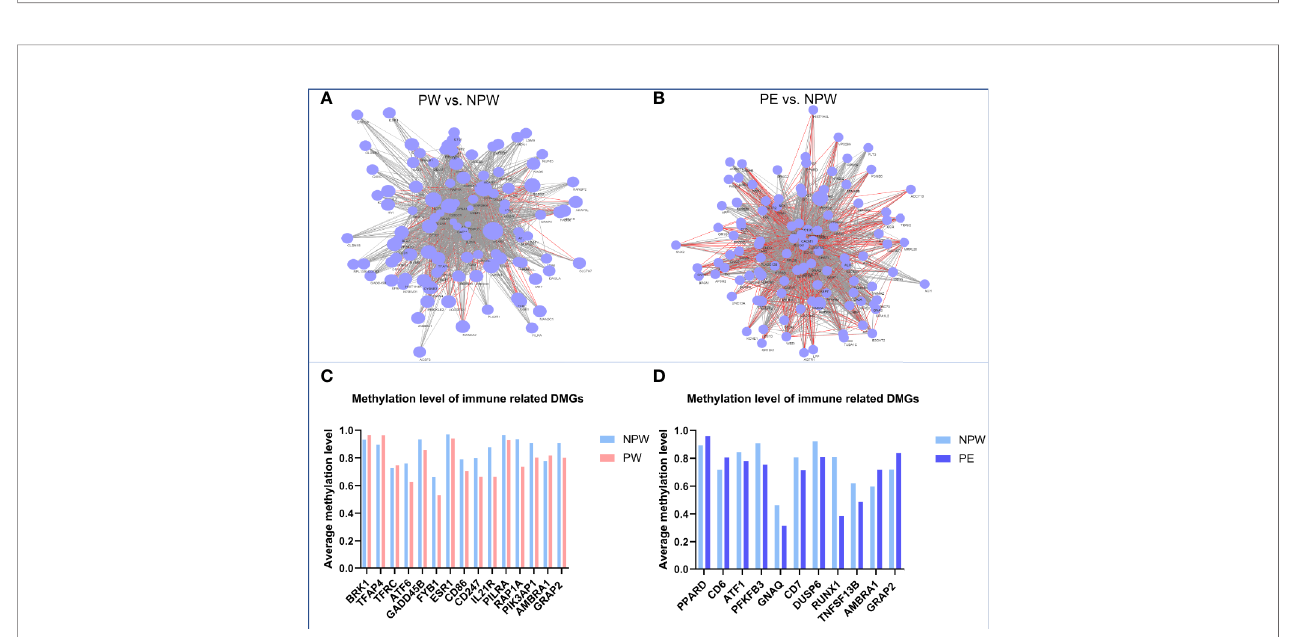
FIGURE 7 | Network diagram of methylation levels of signi fi cant DMGs and cell subset modi fi cation related DMGs in each KEGG pathway in the PW and PE groups. (A) Methylation levels of the signi fi cant DMGs in 201 KEGG pathways in the PW group compared to those in the NPW group. The larger the node is, the higher the methylation level of the genes in the PW group compared to the NPW group. The gray line between two genes represents the near-identical methylation changes (both increased and decreased) between the two compared groups, while the red line represents opposite methylation changes between the groups. (B) Methylation levels of the signi fi cant DMGs in 196 KEGG pathways in the PE group compared to the NPW group. The larger the node is, the higher the methylation level of the gene in the PE group compared to the NPW group. The gray line between two genes represents the near-identical methylation changes (both increased and decreased) between the two compared groups, while the red line represents opposite methylation changes (one hypermethylated gene and one hypomethylated) between the two compared groups. (C) Average methylation levels of T cell- and NK cell-related DMGs in the PW and NPW groups. (D) Average methylation level of T cell-related DMGs in the PE and NPW